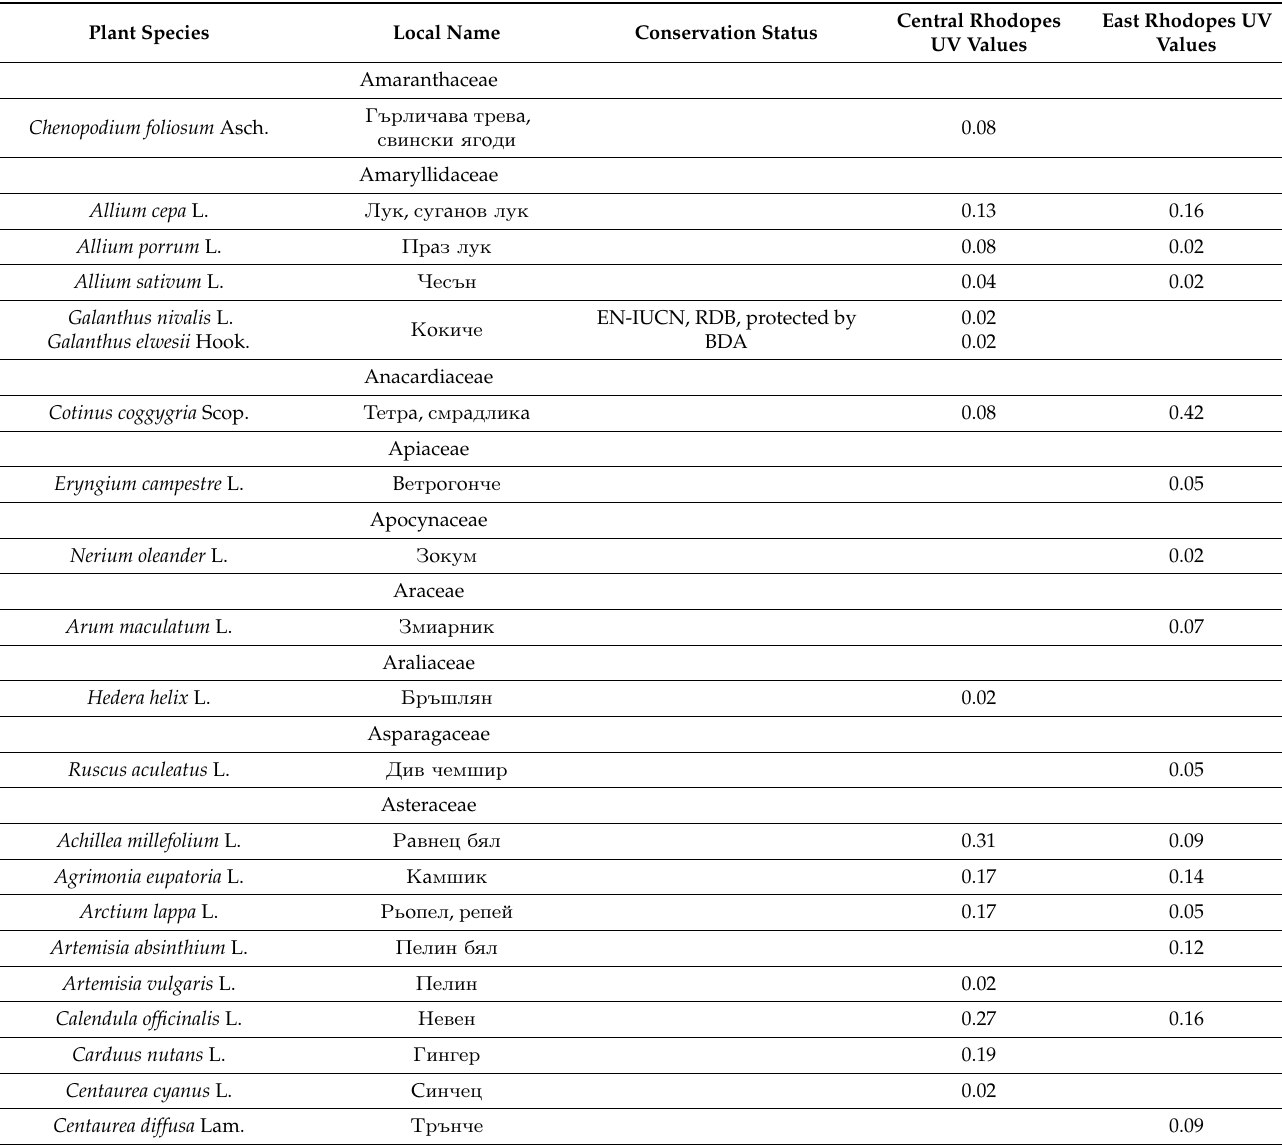
Table 1. Plant species reported for human health usage in Central and East Rhodopes—UV (%) values for therapeutic or prophylactic purposes and conservation status; Legend: MOEW Ministry of Environment and Waters, RDB—Red Data Book of Bulgaria, EN—Endangered, CR—Critically endangered, BDA—Biodiversity Act of Bulgaria, Bal—Balkan endemic. Note: most of the listed plants are common with wide distribution; R. fruticosus does not occur in Bulgaria, but since this is the name coined in pharmaceutical practice, we used it to mark all Rubus species with black fruits reported by